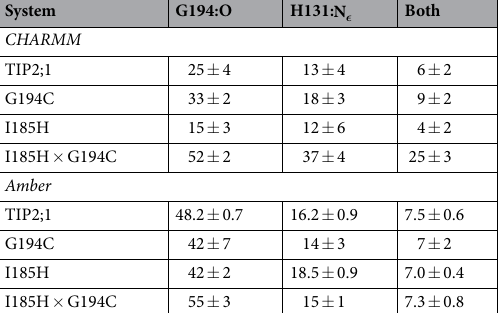
Table 1. Probabilities per water molecule of hydrogen bonding to SF sites (%). The given values are probabilities of a water molecule located in the SF region, here defined as 6 Å < z < 9 Å and d xy < 7 Å, to hydrogen bond to either of the listed pore sites, or to both.